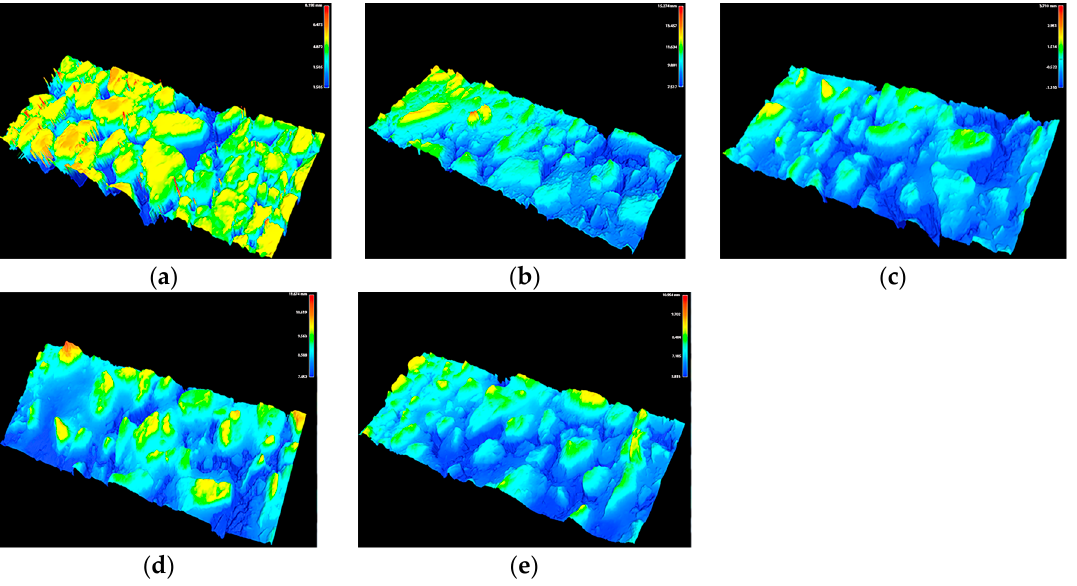
Figure 9. Morphological changes of surface texture: ( a ) kneading for 0 h; ( b ) kneading for 2 h; ( c ) kneading for 4 h; ( d ) kneading for 6 h; and ( e ) kneading for 8 h.